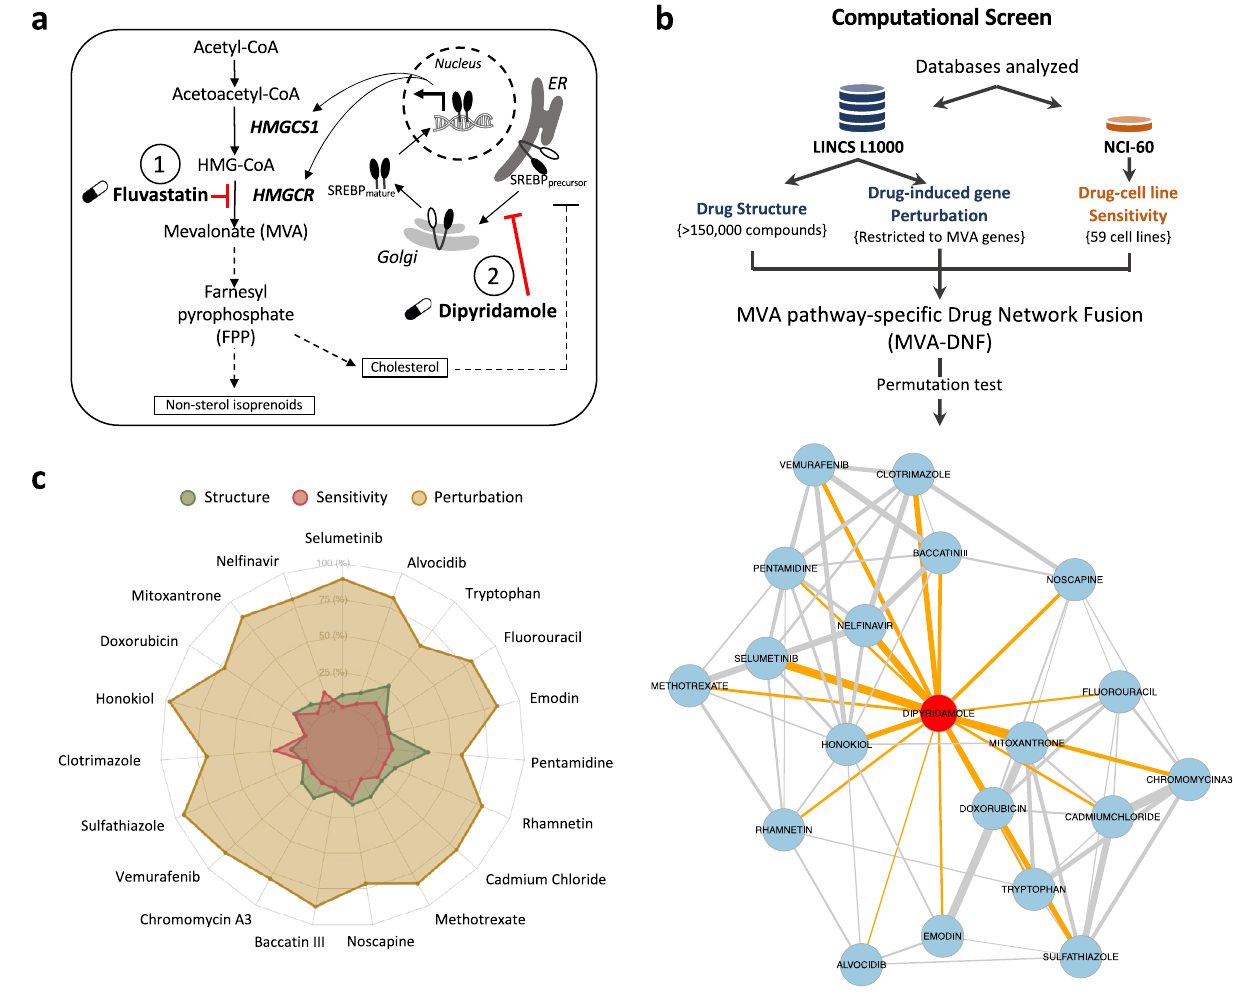
dipyridamolewasassessedbycomparingto999networksgeneratedfromrandom selectionofsixgeneswithinthedrugperturbationlayer.Anetworkrepresentation of dipyridamole and the top19 statistically-signi fi cant ( p -value <0.05) compounds are shown. Each node represents a compound, and edges connect compounds based on a statistical signi fi cance cutoff of p -value <0.05. Blue nodes and orange edges represent the compounds connected to dipyridamole, and edge thickness representstheassociatedp-valuebetweenthecompounds. c Radarplotofthetop 19 compounds ( p -value <0.05), where the contribution of each individual layer of the MVA-DNF (drug structure, perturbation, and sensitivity)isdepicted.Theradar plotwasgeneratedbycomparingthescoreofDPandthetophitcompound,across the af fi nity matrices of the perturbation, structure, and sensitivity layers. The percent contribution of each layer is shown from the center (0%) to the outer edges